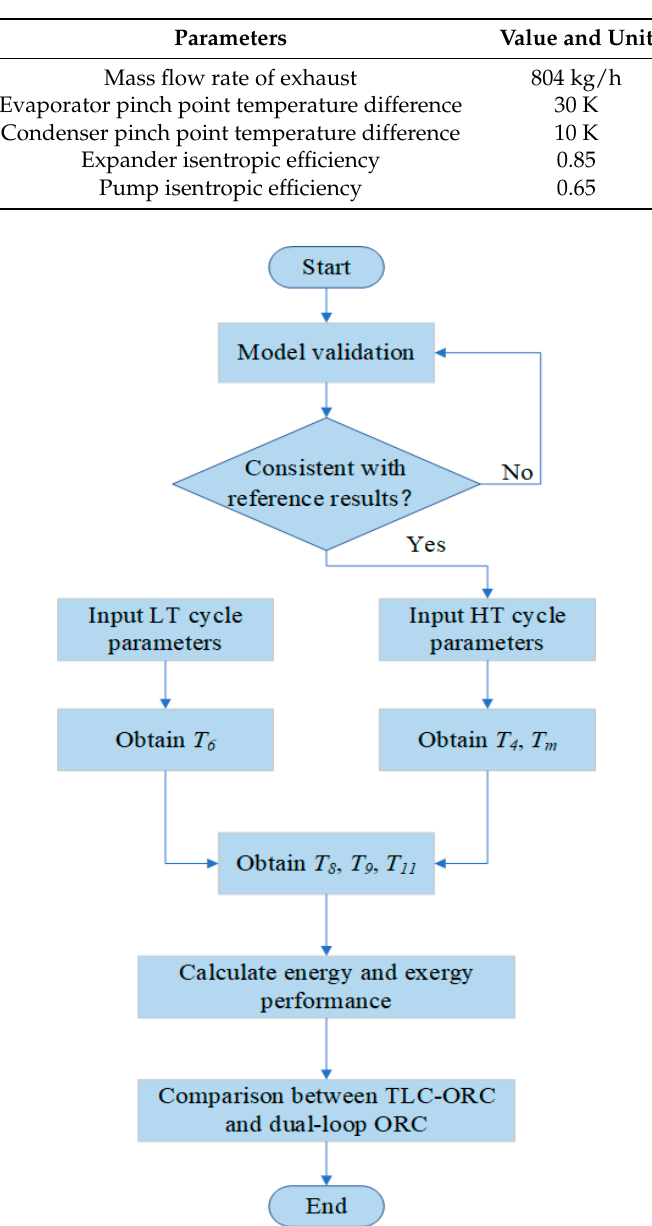
Figure 4. Flowchart of the simulation model.